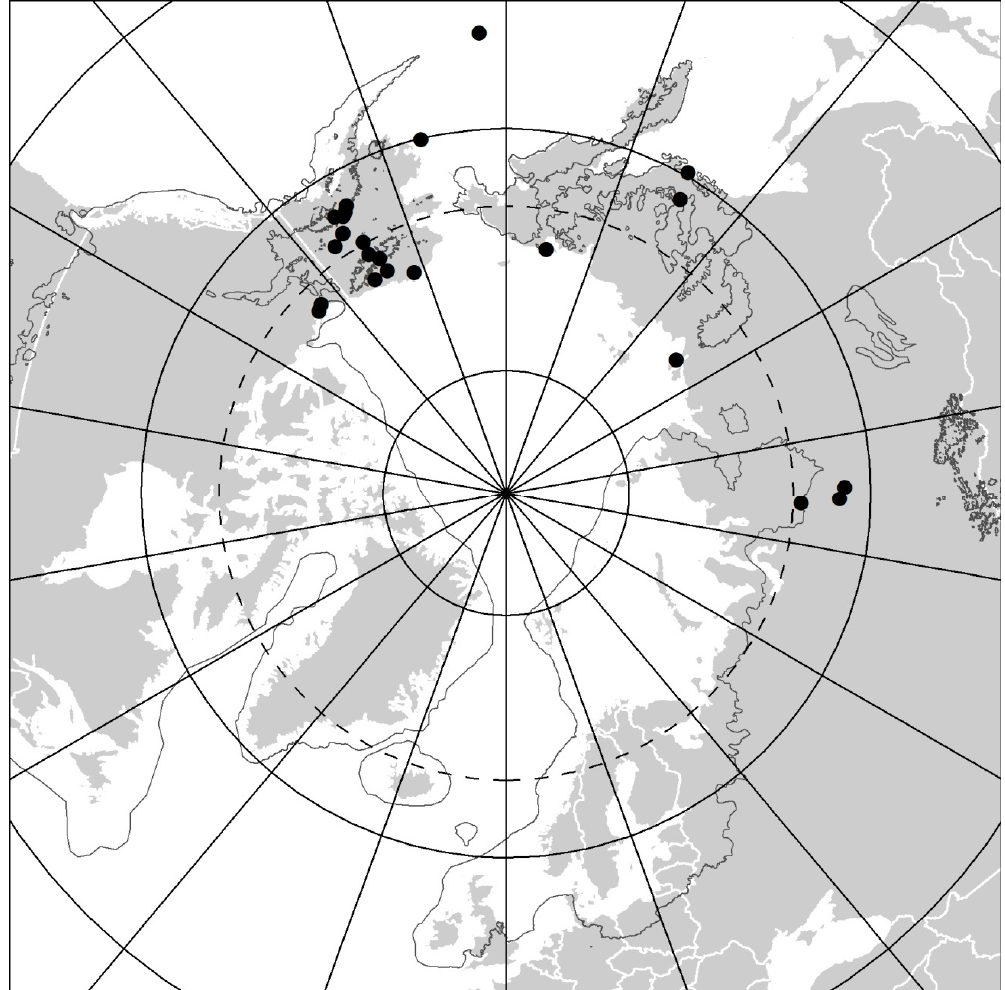
Figure 1. Map showing all known sites of Protura occurrence within the Arctic regions. The dark grey irregular line shows the largest ice-sheet extent during the Pleistocene Last Glacial Cycle (redrawn after Reference [32]).